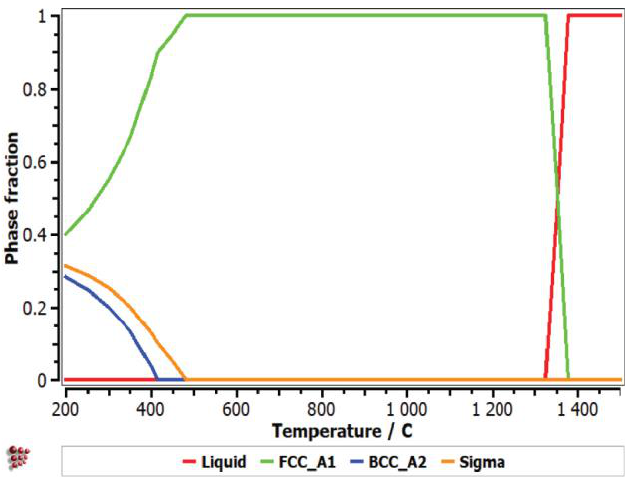
Figure 3. Equilibrium diagrams for the CoCrFeMnNi alloy.